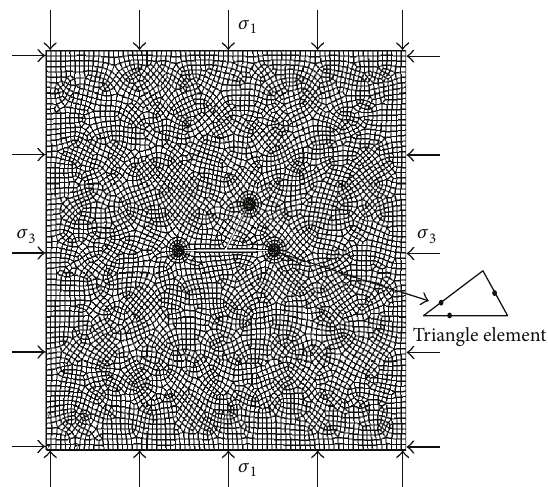
Figure 5: Elements applied in dividing the domain containing Y-shaped cracks.